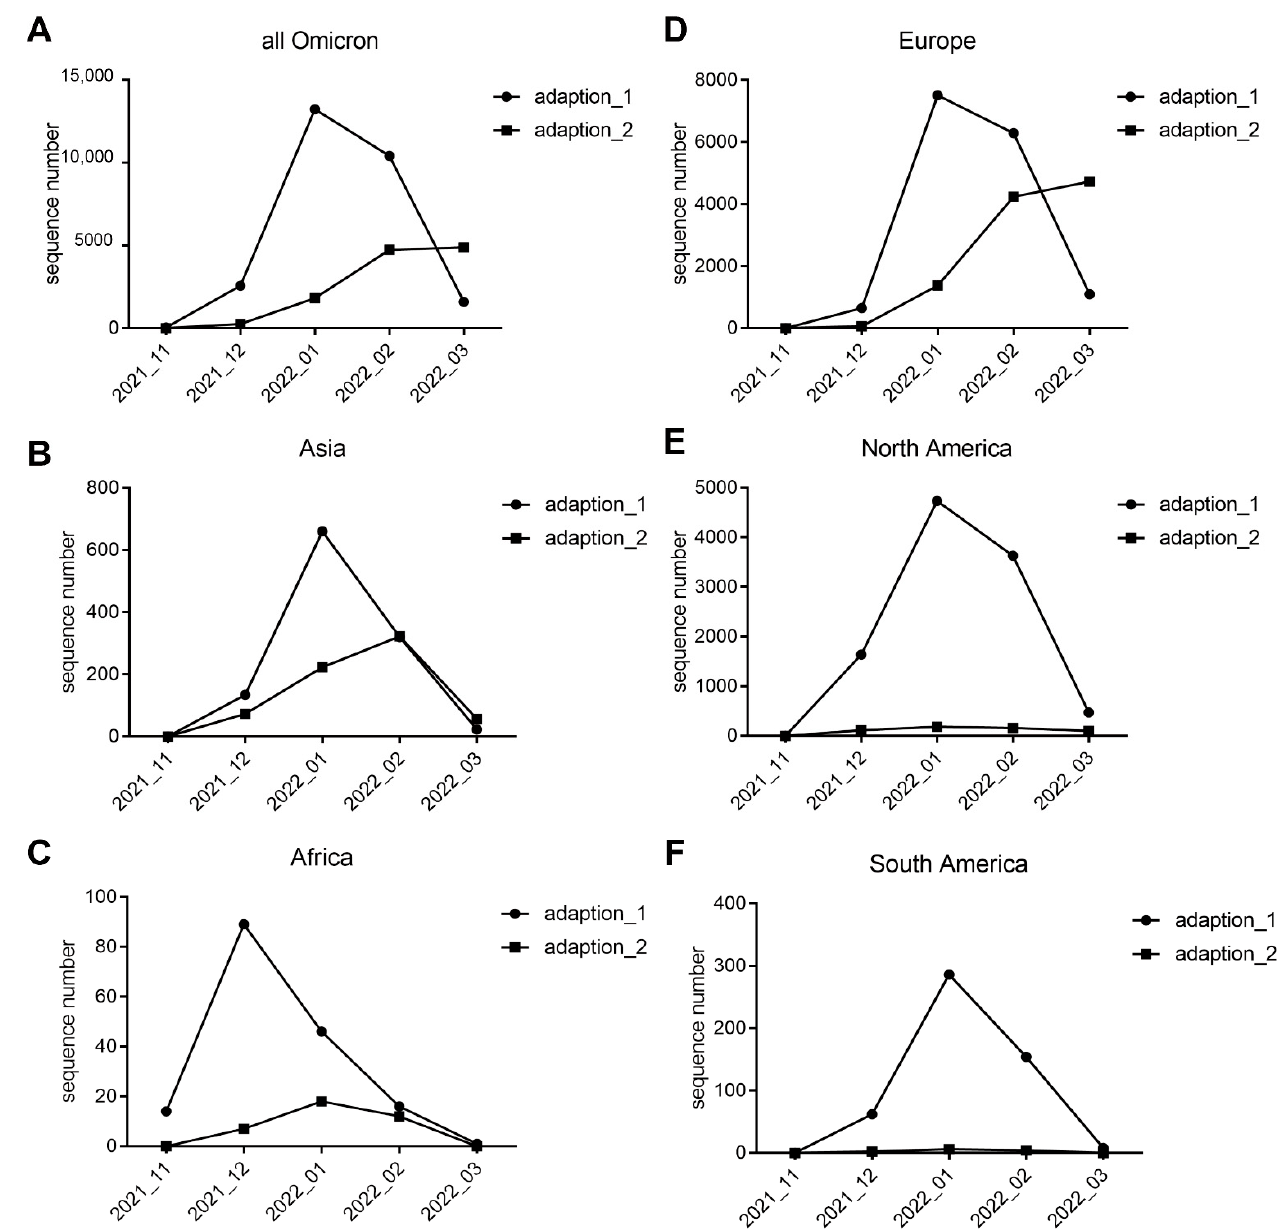
Figure 5. Prediction and prediction probability of Omicron sublineages. ( A ) Temporal analysis of Omicron variants which were predicted for their human adaptation (adaptation_1 and 2, the only 1 sample with adaptation 0 was excluded); ( B – F ) Spatial distribution of the Omicron variants with the predicted adaptation, 1 or 2, in Asia ( B ), Africa ( C ), Europe ( D ), North America ( E ), and South America ( F ).